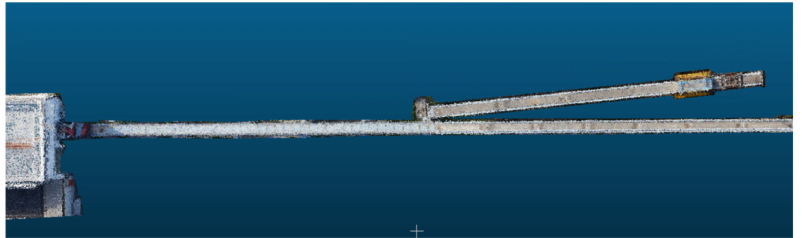
Figure 12. Illustration of the dense point clouds of the magnetic floating turnout